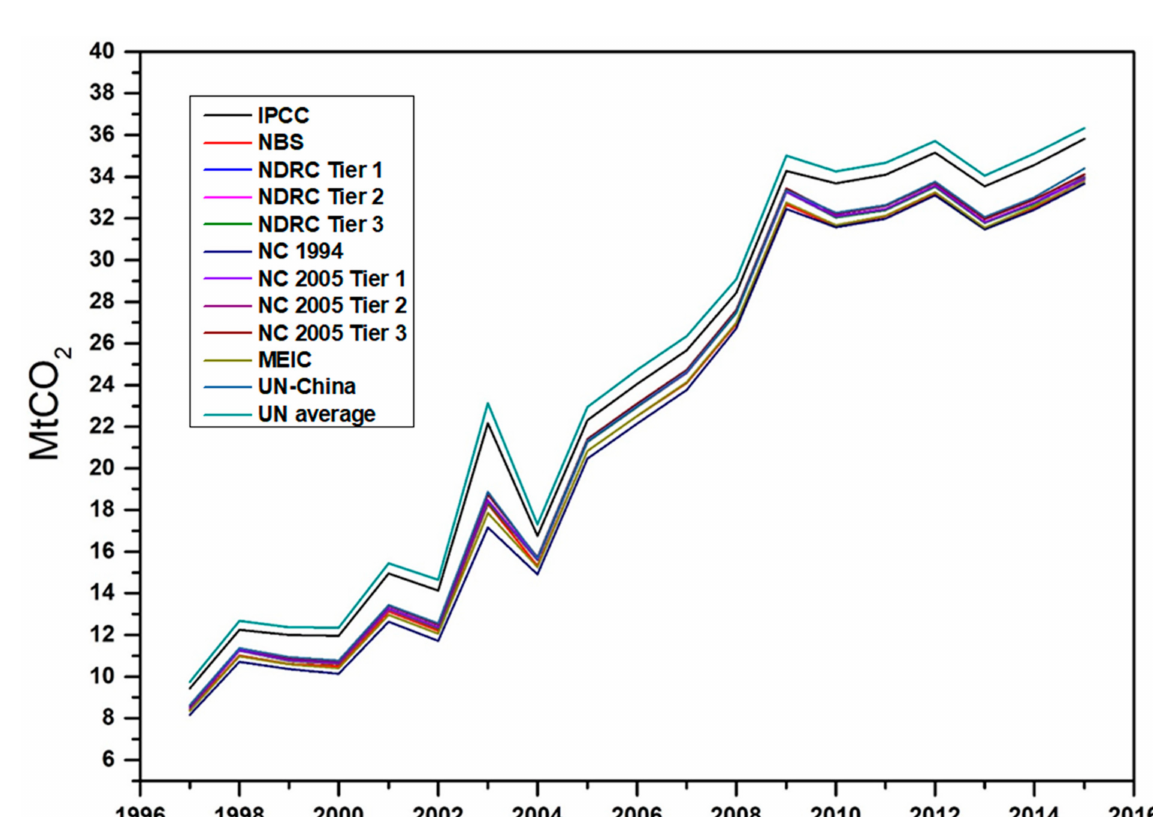
Figure 3. National direct CO 2 emissions in China’s construction